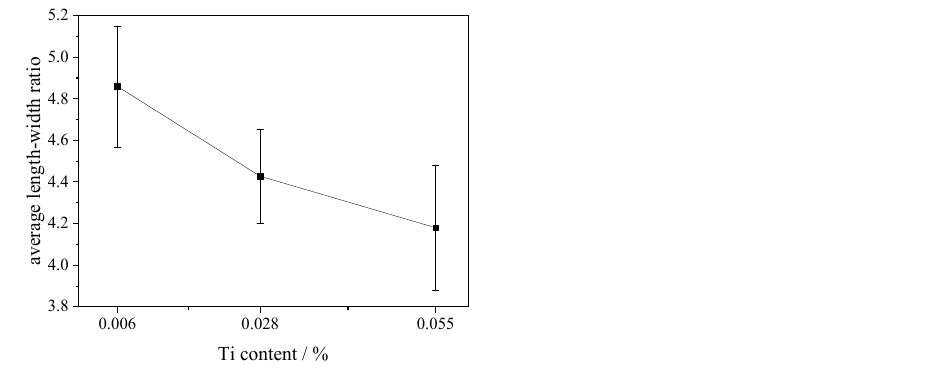
Table 2. Composition and proportion statistics of sulfides in three steel samples under rolling. Ti